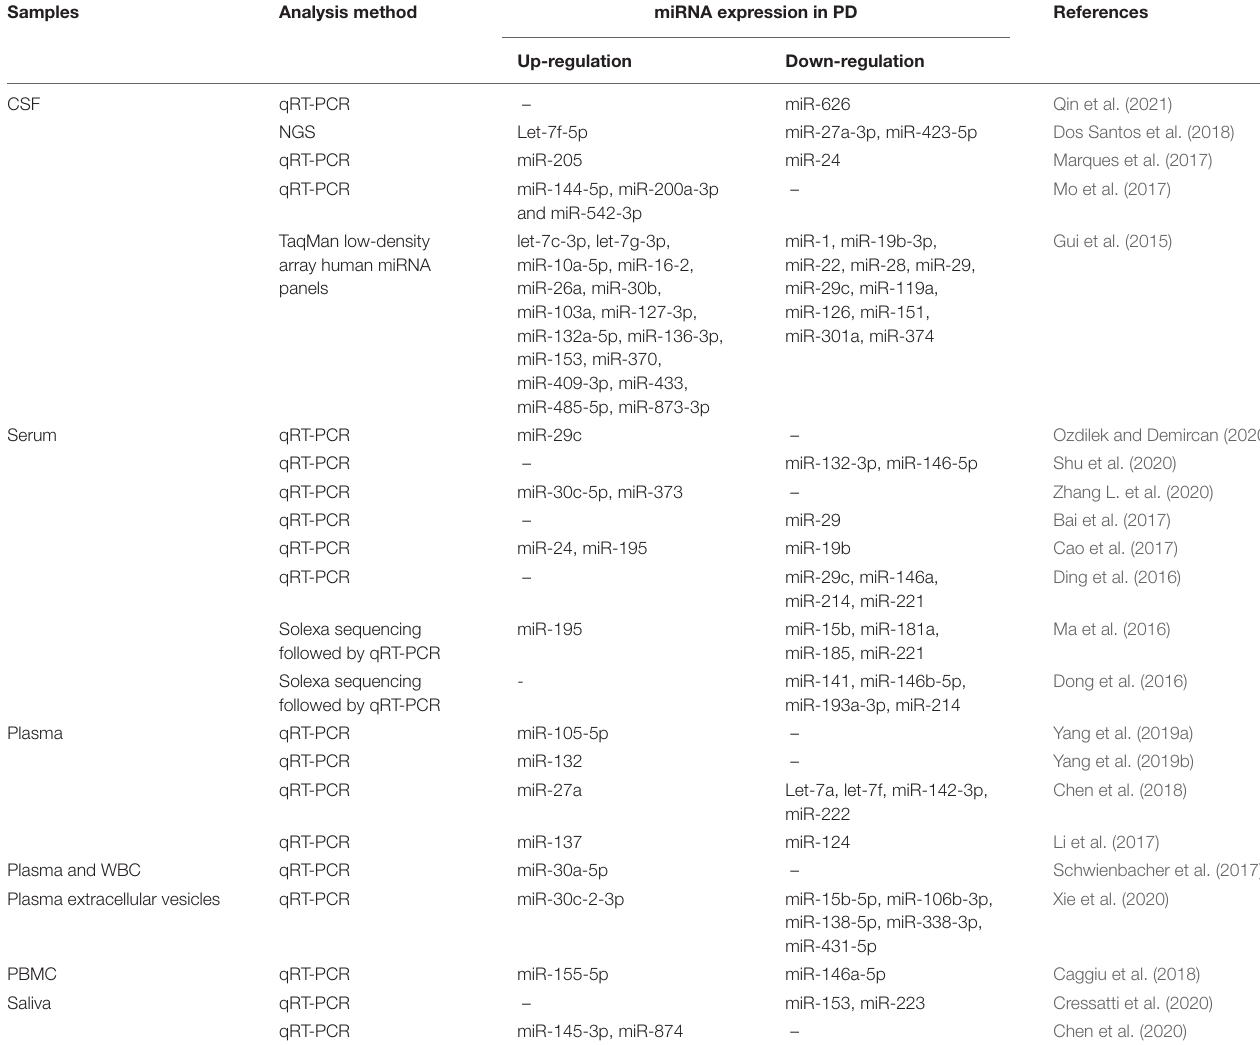
TABLE 2 | Circulating miRNA profile from PD patients.